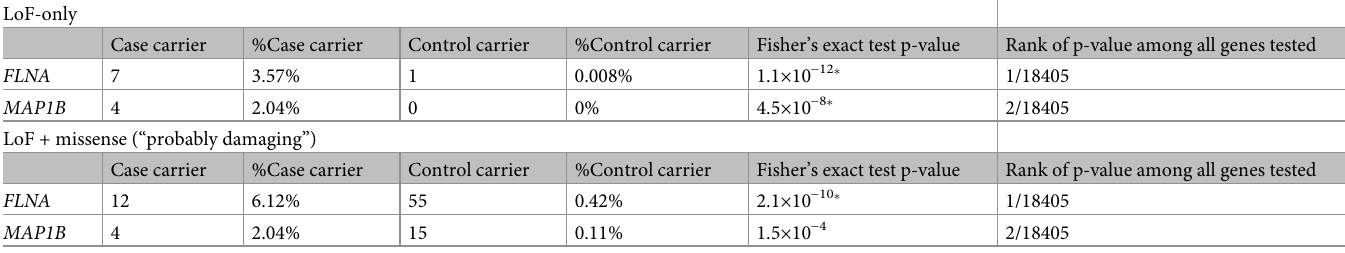
Table 2. Top associations from the gene-level case-control collapsing